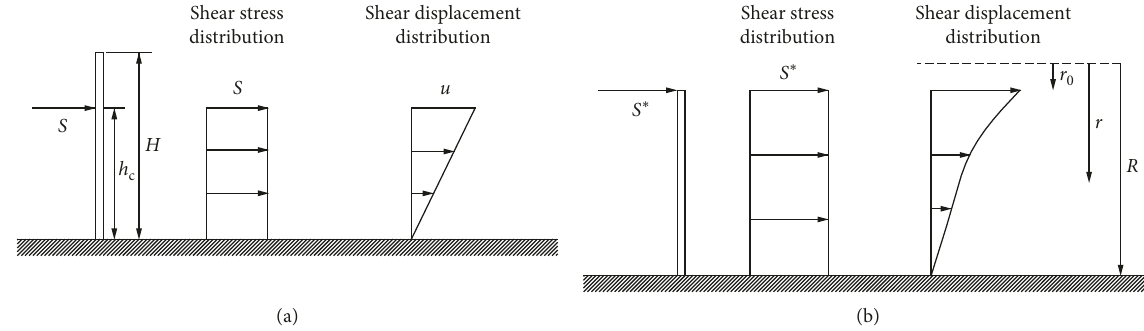
Figure 6: Relationship between the concentrated force and ground shear deformation along the longitudinal direction of a tunnel in (a) the actual ground and (b) the axisymmetric model.